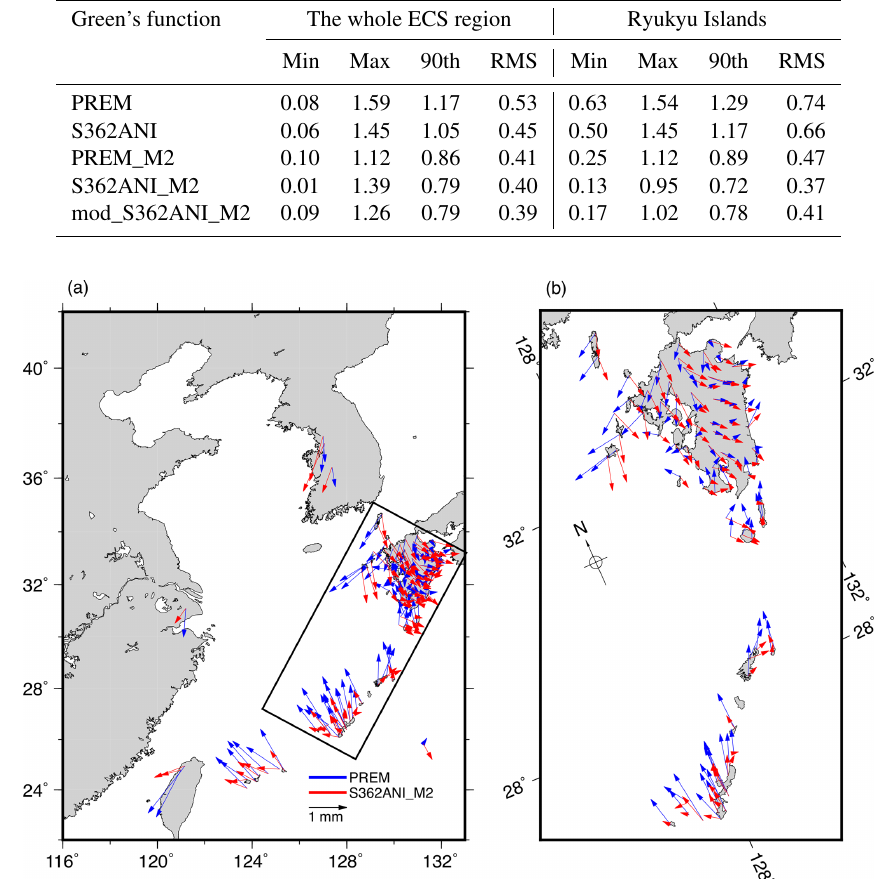
Figure 5. Phasor differences between our GPS-observed M 2 vertical OTL displacements and the predictions computed using the NAO99Jb regional ocean tide model (augmented elsewhere globally with FES2014b) and the elastic PREM (blue phasors) and S362ANI_M2 (red phasors) Green’s functions. Panel (a) shows the whole ECS region, while (b) is an enlargement of Kyushu and part of the Ryukyu Islands, for the boxed region in (a)